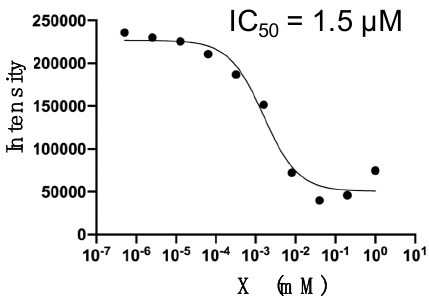
Figure 3 . Docking scores, IC 50 values and measurements of compounds 1–6 . All compounds showed larger scores than that of X (score = − 42.96) with a few hundred μ M of IC 50 values.